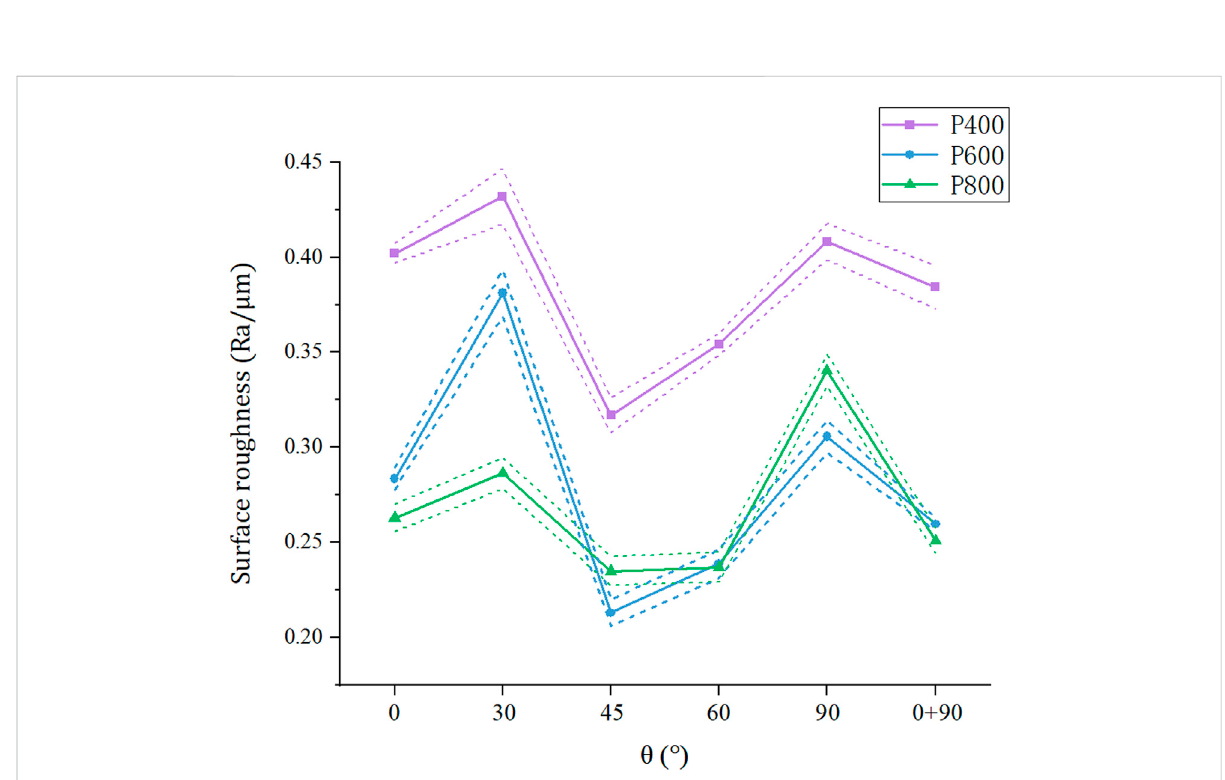
FIGURE 6 Surface roughness results for different trajectory